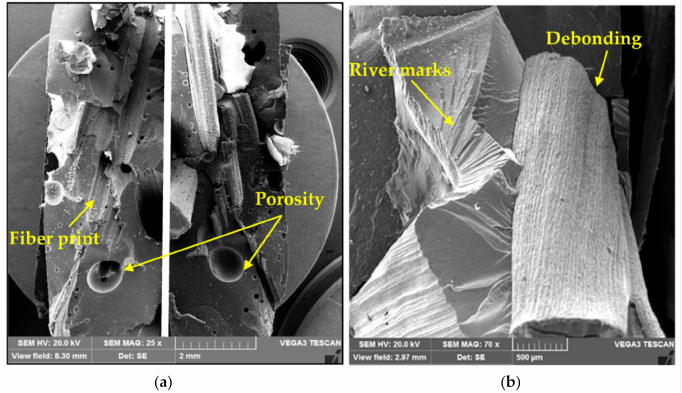
Figure 11. SEM images of fracture surfaces of composites with alkali-treated ra ffi a fibers with a length of 15 mm: ( a ) defects in both parts of the sample, and ( b ) fracture